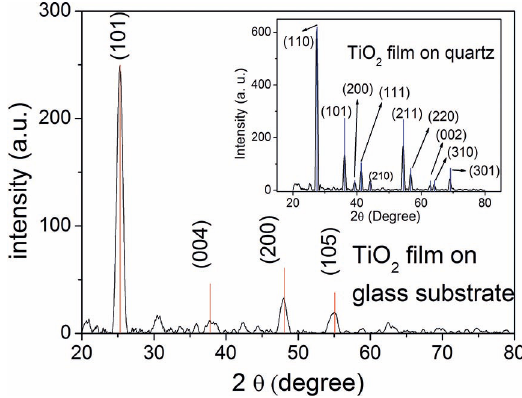
thin film deposited on glass substrates. Red Figure 4. XRD of TiO 2 lines refer to Anatase (catalog JCPDS-ICDD 2003 file number 78- 2486). Inset: XRD diffractogram for TiO film deposited on quartz 2 substrate. Blue lines refers to rutile phase (catalog